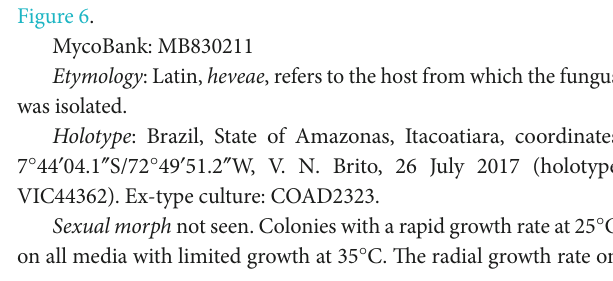
CMD was 77.5 mm at 25 ° C, 70.5–72.5 mm at 30 ° C, and 11.5–12.5 mm at 35 ° C, after 72 h. Colonies thin, surface downy, floccose or farinose, yellowish-green to green. Chlamydospores globose, terminal, and intercalary. Sporulation starting after 2 days; dark green, fluffy tufts, or loose pustules, with irregular or circular outlines, arranged in several indistinctly separated concentric zones. Conidiophores formed along with main axes, with long branches at lower levels, and sparse, widely spaced, solitary or paired phialides; or short, one-celled side branches bearing terminal whorls of 2–3 phialides, slightly inclined or curved